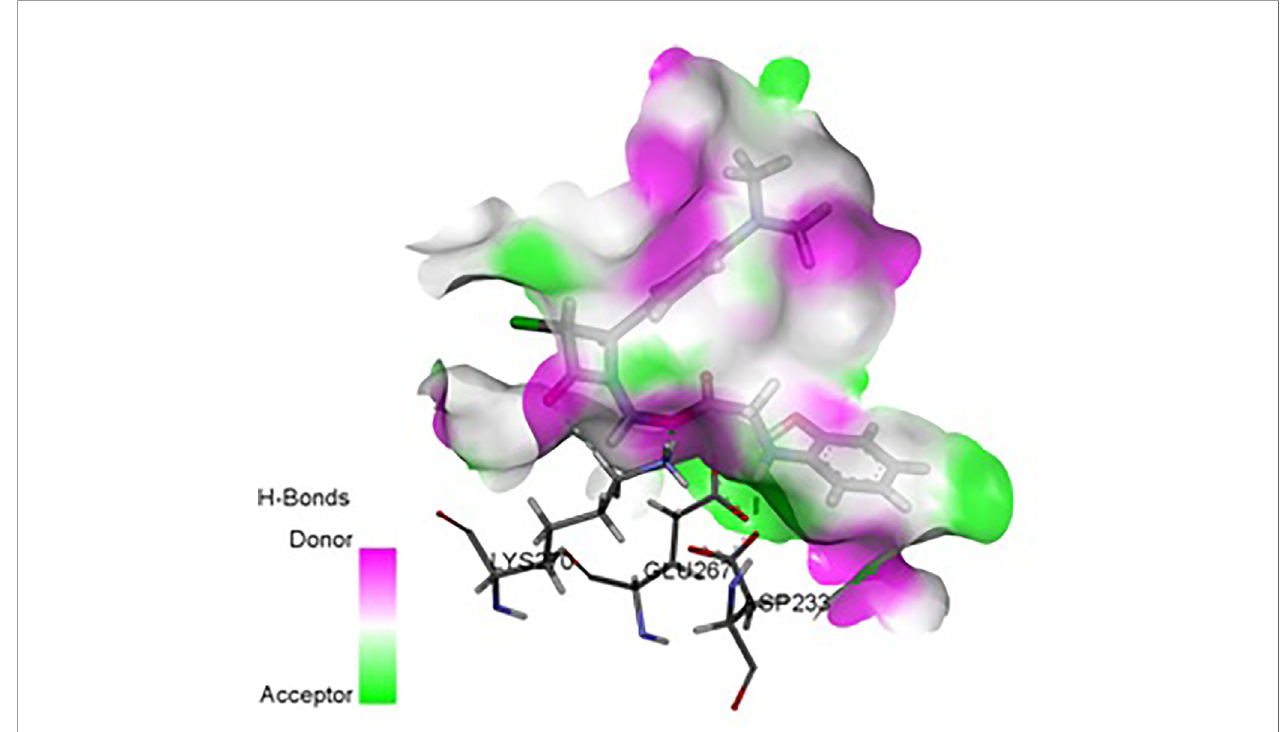
FIGURE 15 | 3D Interaction of ND5 with